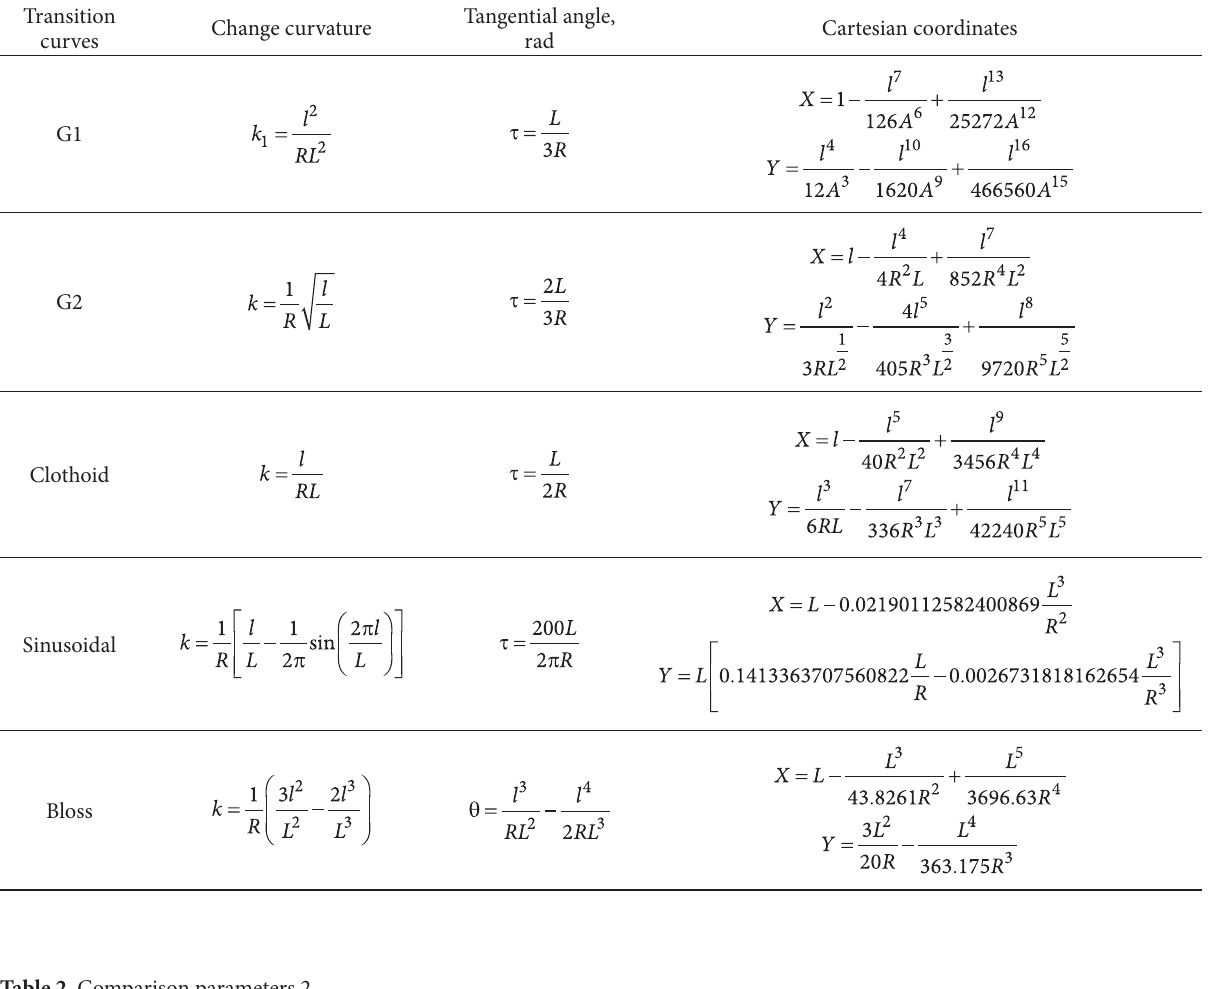
Table 2. Comparison parameters